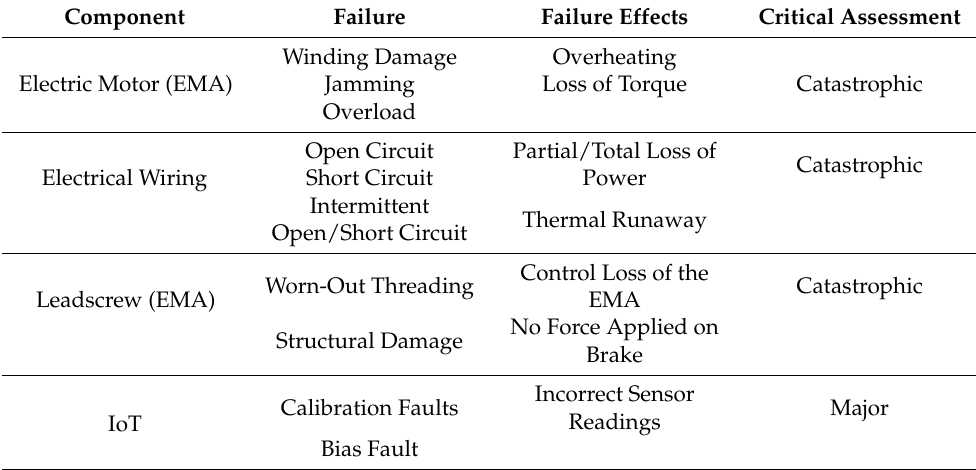
Table 1. Simplified FMECA from an